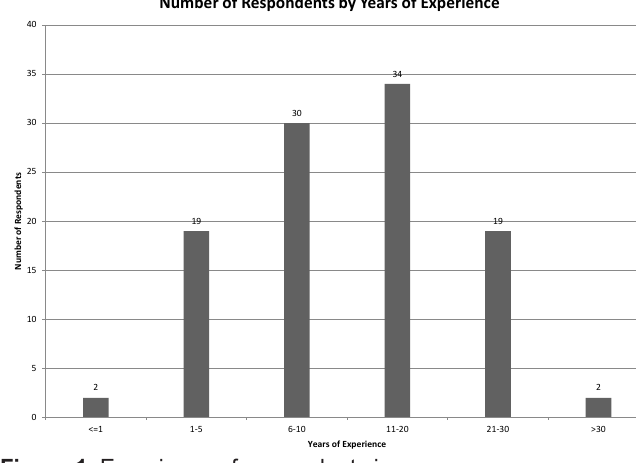
Figure 1. Experience of respondents in years. Table 2. Collisions reported by emergency medical service